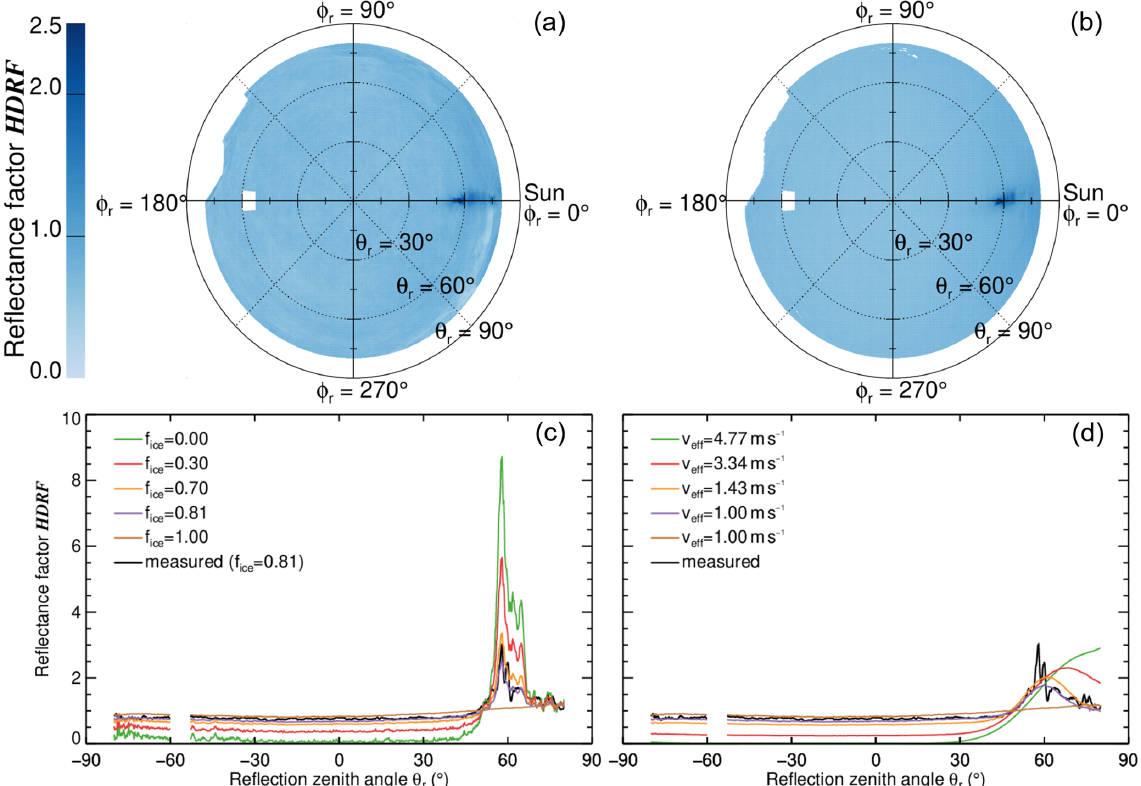
Figure 11. Polar plot of (a) the mean MIZ HDRF of the test data set (obtained by averaging over all images without separation) and (b) the constructed MIZ HDRF (calculated from the separated sea ice and open-ocean HDRFs of the separation data set according to Eq. 5 using a sea ice fraction of 0.83). (c) Cross-section of the constructed MIZ HDRF along the solar principal plane obtained from the separated HDRFs of the separation data set for different sea ice fractions f ice (color-coded) and the mean MIZ HDRF of the test data set (black). (d) same as (c) , but sea-ice-fraction-dependent simulations were used for the open-ocean HDRF; see text for details.